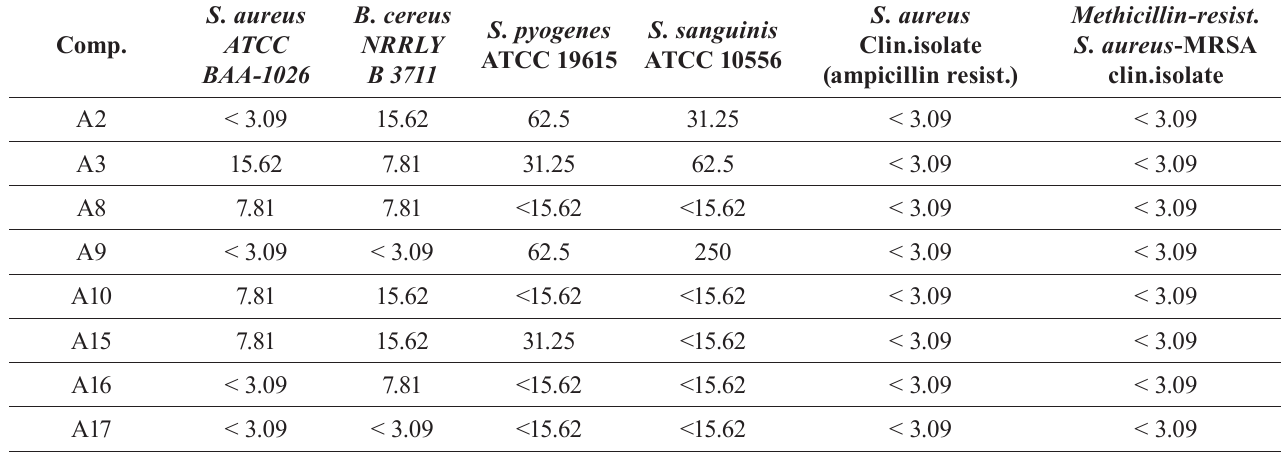
TABLE III – Antimicrobial (MIC µg/mL) effect of compound V(A2,A3,A8,A9,A10,A15,A16,A17,A18,A23 and A24)